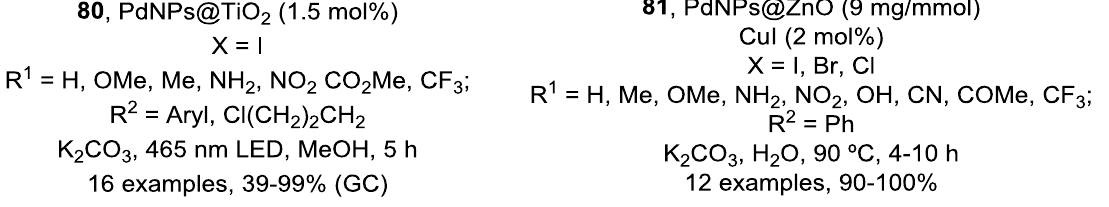
Figure 24. Titania and zinc oxide-immobilized PdNPs as catalysts for the Sonogashira reaction. Conditions, substrate scope and yield range (Scheme